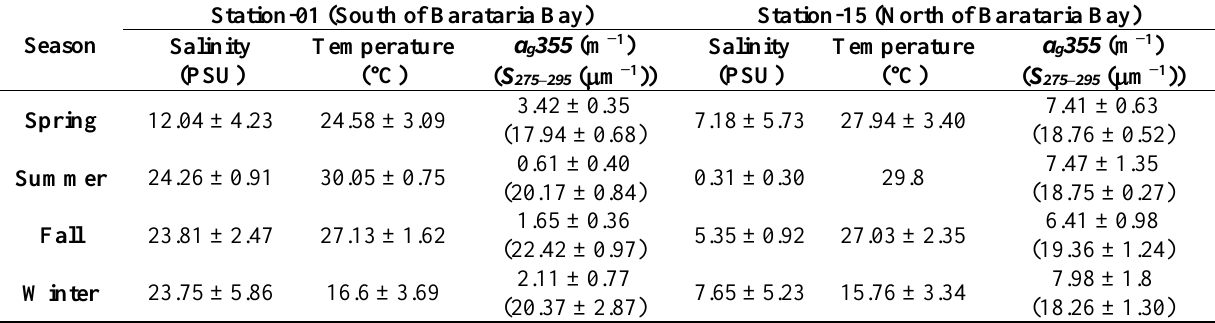
Table 3. Salinity, temperature, a g 355 and S during spring, summer, fall and